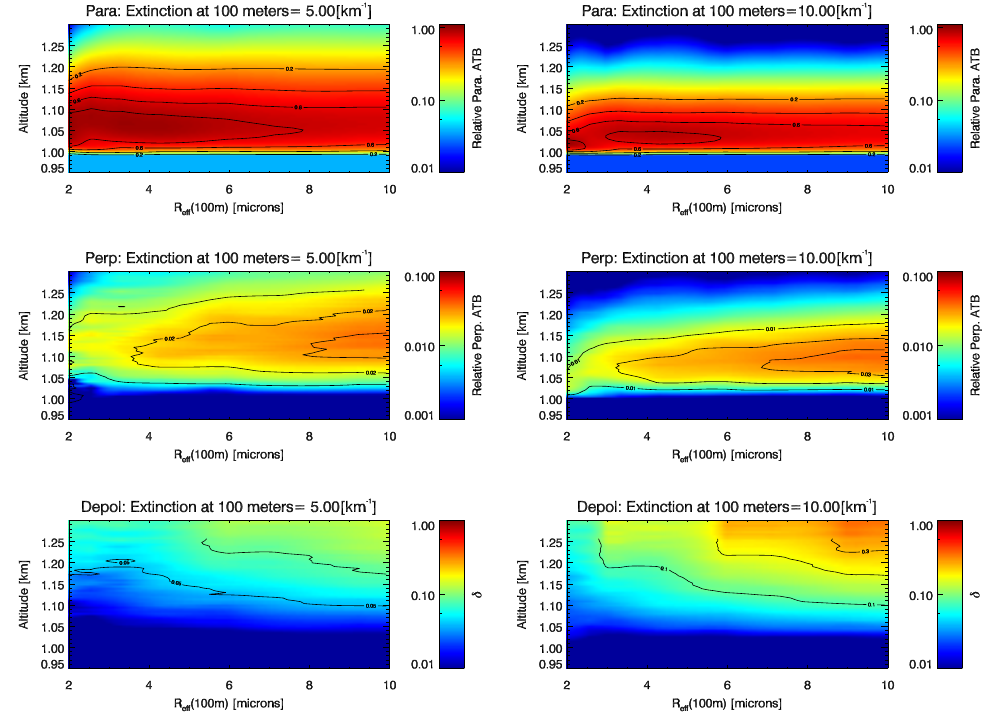
Figure 4. Example results of MC calculations for a lidar wavelength of 355nm corresponding to semi-infinite clouds with a cloud-base of 1.0km for two values of α 100 as a function of R eff,100 for a lidar FOV of